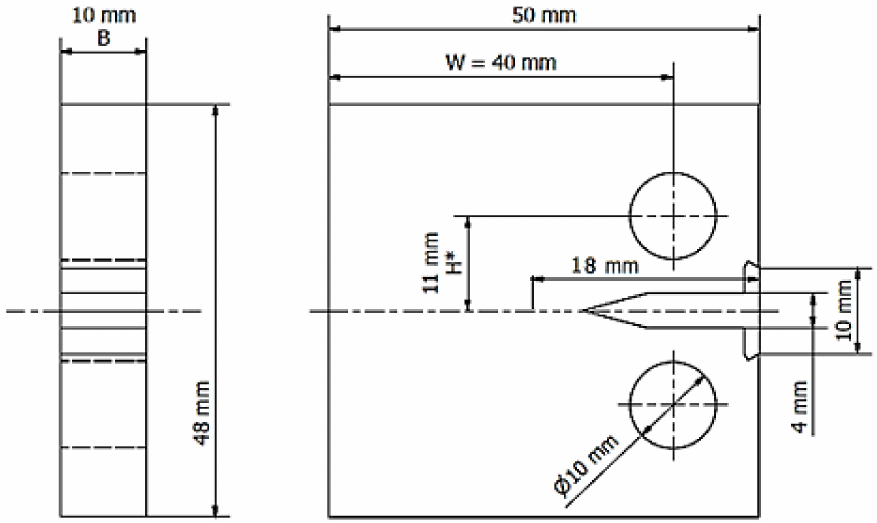
Figure 1. Basic dimensions of a compact specimen used for tests of fracture toughness.